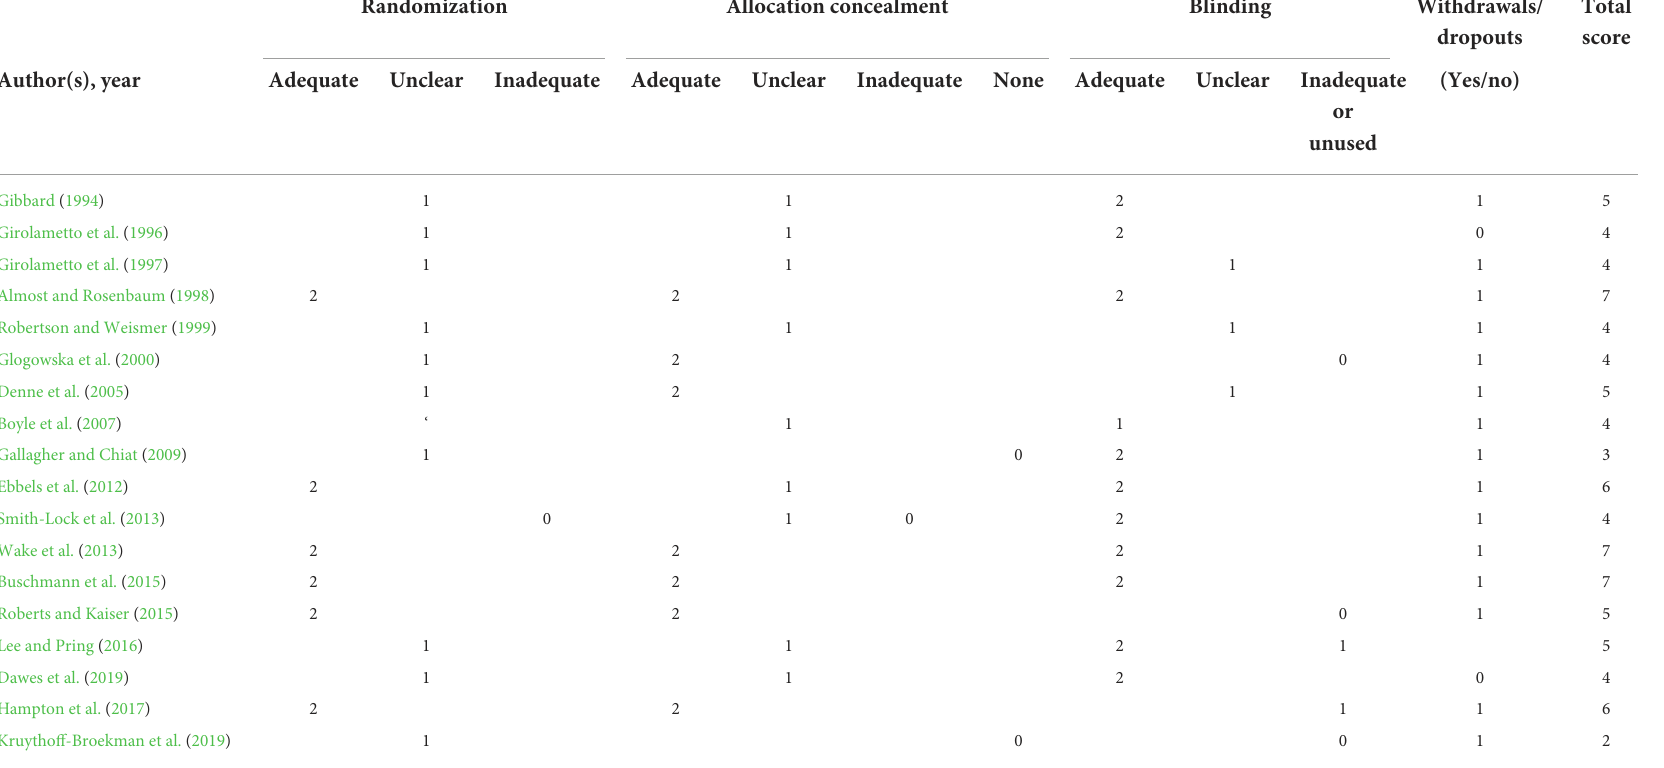
TABLE 1 Quality assessment of the publications included in this study using the modified Jadad